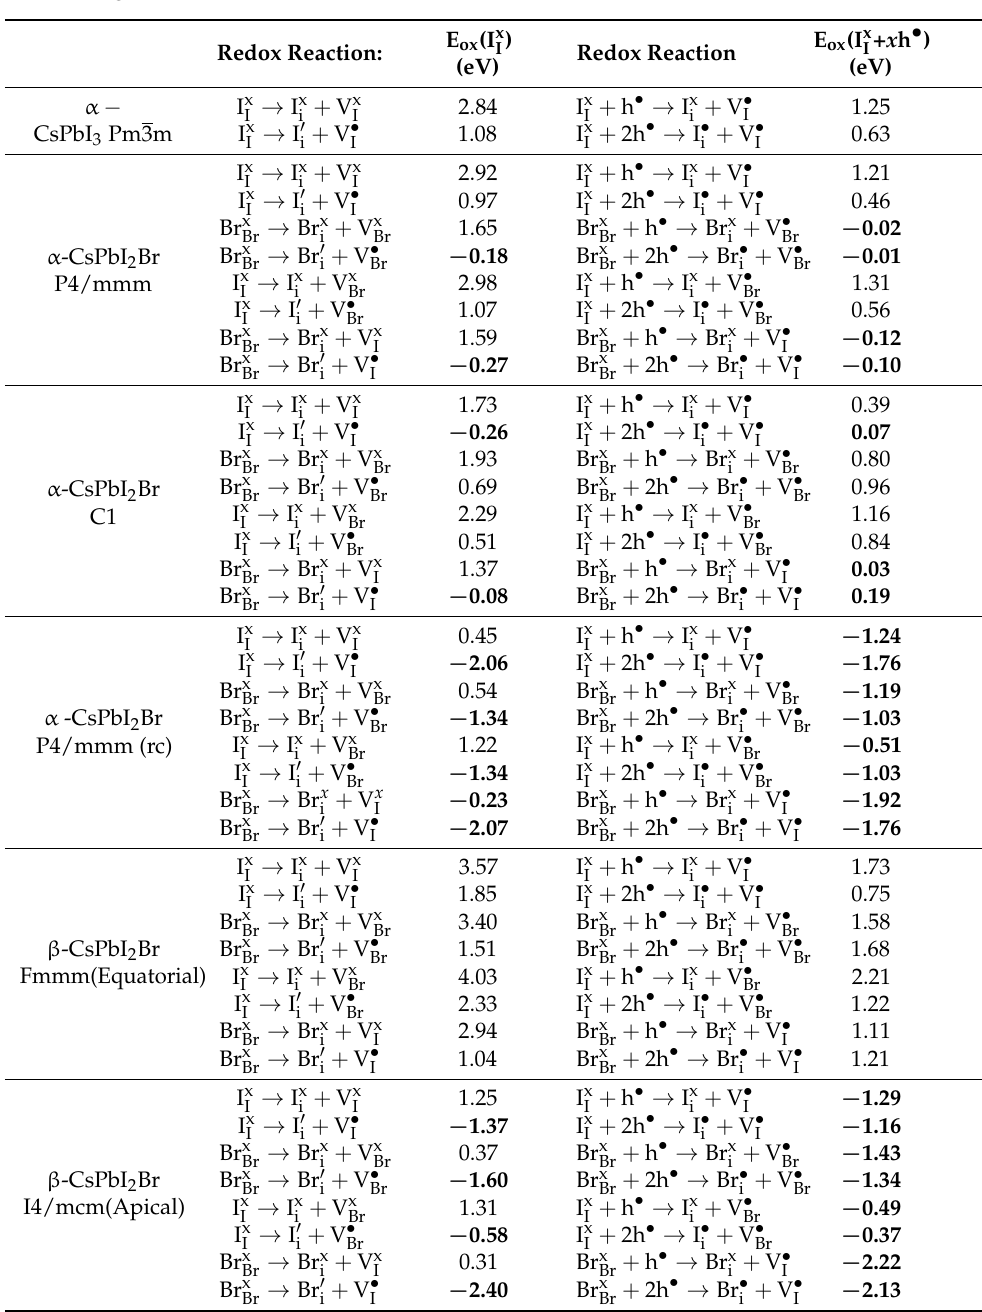
Table 4. Energies of the neutral, hole-coupled and bihole-coupled Frenkel oxidations E ox for α -CsPbI 3 Pm 3 m , α -CsPbI 2 Br P4/mmm (stochastic), α -CsPbI 2 Br C1 (cluster), α -CsPbI 2 Br P4/mmm with the coordinate system rotated by 45 ◦ , β -CsPbI 2 Br Fmmm (equatorial) and I4/mcm (apical). We indicate negative or near-zero values with bold